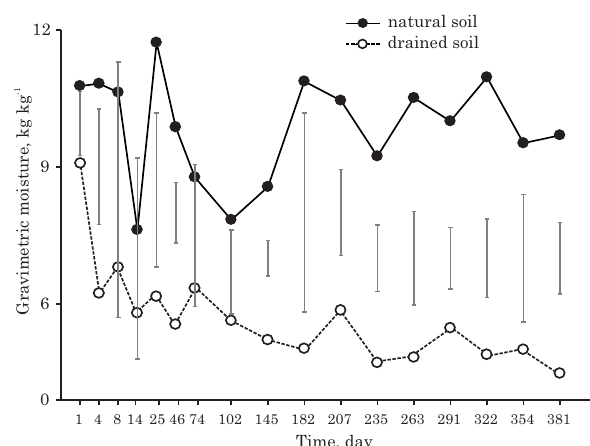
Figure 4. Gravimetric moisture in the 0-10 cm layer of natural and drained Histosols under grassland waterlogged vegetation. Vertical bars represent the least significant difference by Tukey’s test (p < 0.05).